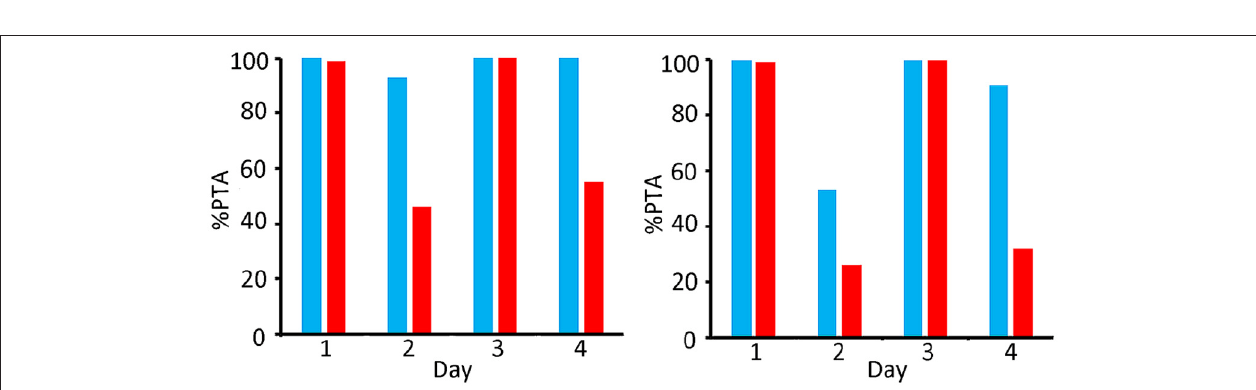
FIGURE 8 | Comparison of PTA [%] for bacteriostatic effectivity (left) and bactericide effectivity (right) of OTC for M. Haemolytica in 400kg (blue) and 100kg (red) steers; dosing regimen 20 mg/kg twice (48h dosing interval).